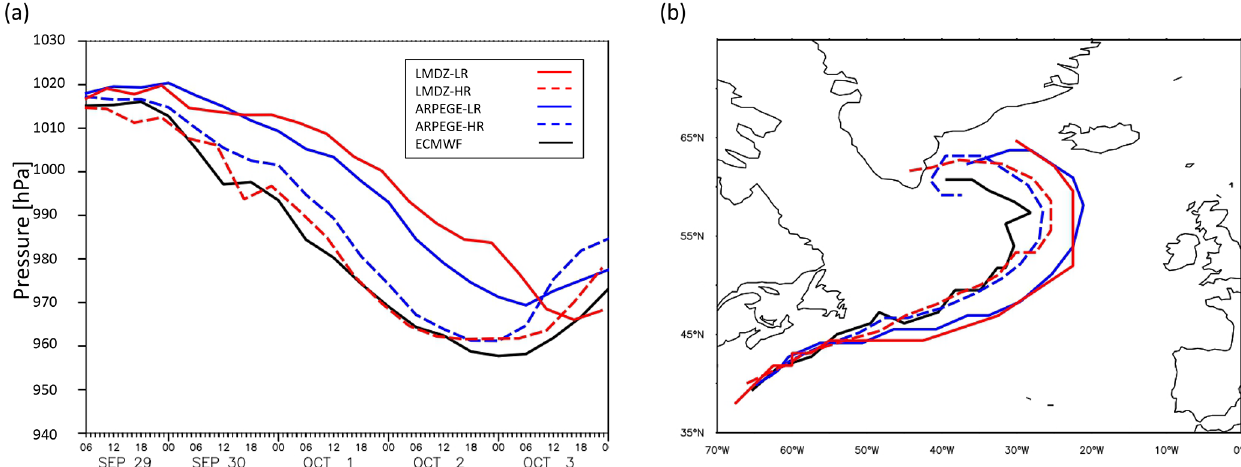
Figure 2. An overview of the Stalactite cyclone: (a) the minimum pressure evolution and (b) the cyclone track. The ECMWF analyses are in black, LMDZ hindcasts in red, and ARPEGE hindcasts in blue. The LR hindcasts are the solid lines, and the HR hindcasts are dashed. All hindcasts are initiated at 00:00UTC 29 September